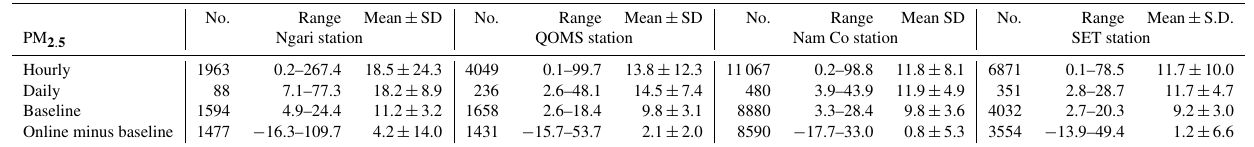
Figure 1. The main landscapes (1 ◦ × 1 ◦ pixel resolution) (a) and the aerosol observation sites in the HTP (b–e) . The highland HTP region is taken as land above 2800ma.s.l., but the thresholds are 1500ma.s.l. for areas 92–97 ◦ E and 26–34 ◦ N, and 2000ma.s.l. for areas 98–104 ◦ E and 24–34 ◦ N, accounting for the regional deviations caused by the extremely steep topography. The classification of landscapes, according to MODIS land cover classification (Broxton et al., 2014), suggests different land covers at these stations (here the forest areas comprise evergreen, mixed, and deciduous forests). Table 2. Concentrations (µgm − 3 ) of hourly, daily and baseline PM 2 . 5 and differences (µgm − 3 ) between online and baseline PM 2 . 5 at four HTP stations for 2011–2013. No. and SD stand for number and standard deviation,